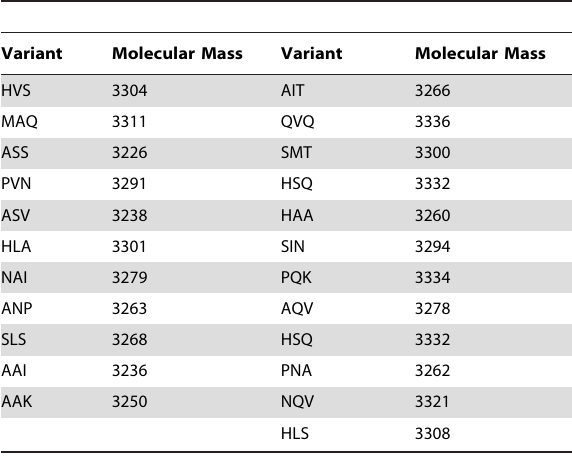
Table 3. Nisin A ‘hinge’ variants with enhanced bioactivity identified through the initial screen.